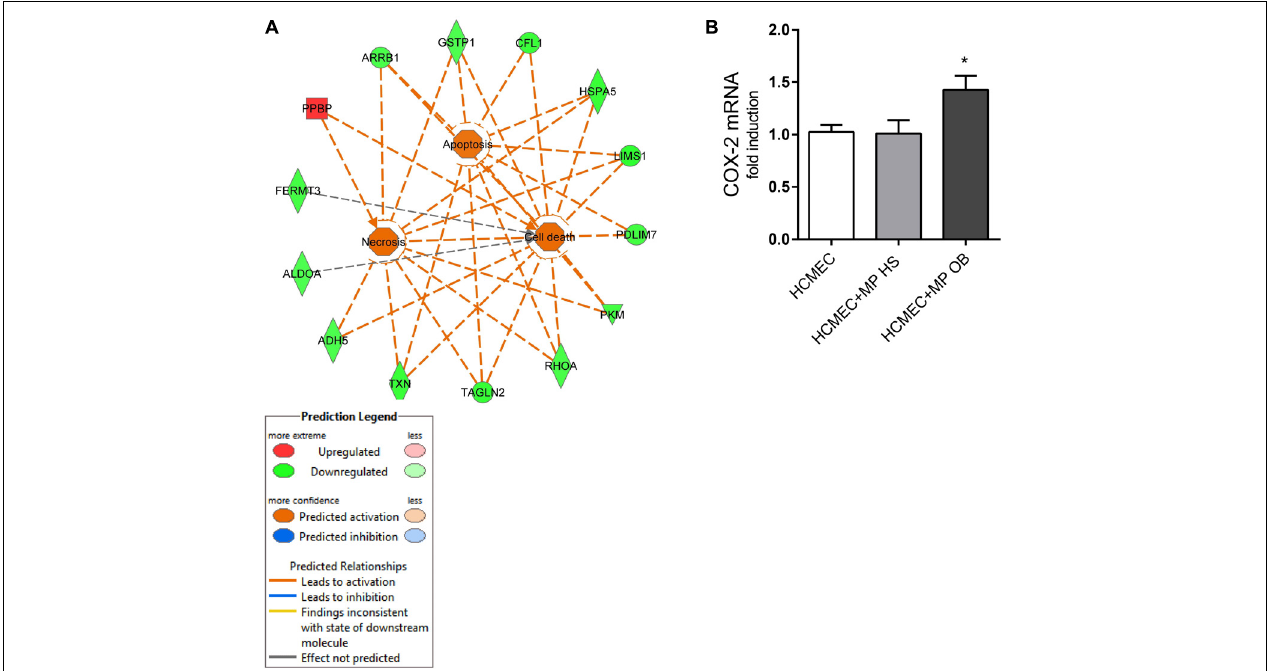
FIGURE 10 | (A) Pathway analysis of modulated MP proteins obtained with IPA for “apoptosis and cell death” signaling is reported. IPA analysis showed regulatory relationships between down-regulated (green) and upregulated (red) proteins; the Molecular Activation Prediction tool showed that “apoptosis, cell death, and necrosis” are positively regulated in obese subjects (orange lines); gray line indicates that the effect is not predicted. (B) In co-culture experiment of HCMEC (0.25 × 10 6 ) and platelet MPs from OB and HS individuals (0.25 × 10 8 ) for 24 h, the gene expression of COX-2 was evaluated by qPCR, normalized to GAPDH levels as control, and expressed as fold-change. Data are reported as mean ± SEM ( n = 4 for each experimental condition); ∗ P < 0.05 vs. HCMEC cultured alone.